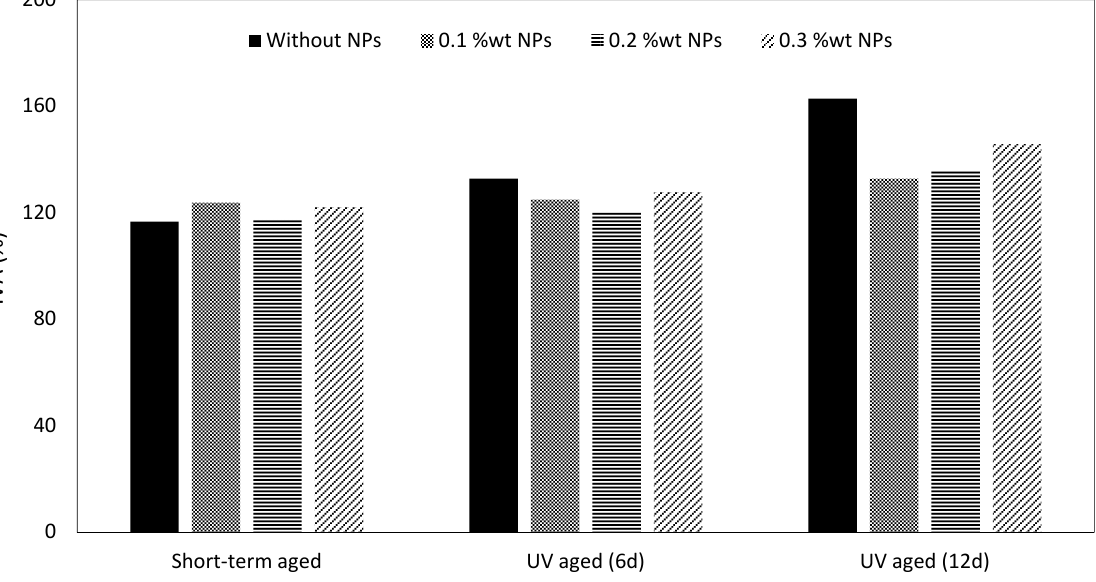
Figure 9. Index of viscosity aging (IVA) of the control and modified bitumen.